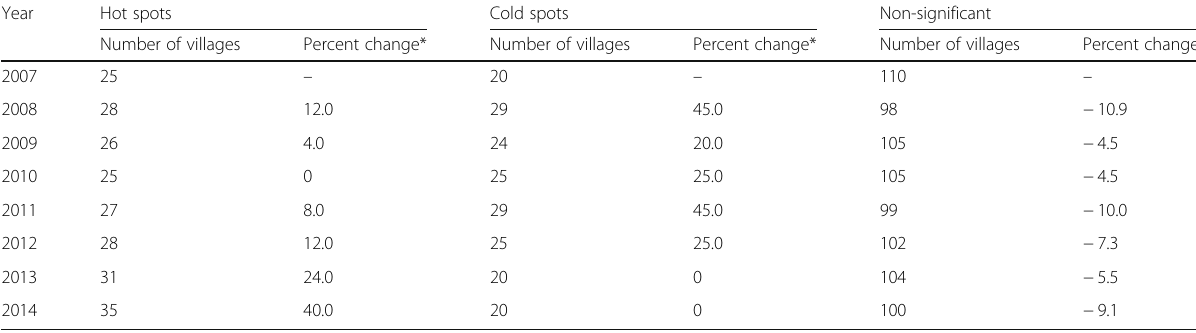
Table 2 The changes in hot spots and cold spots during the study areas (2007 –